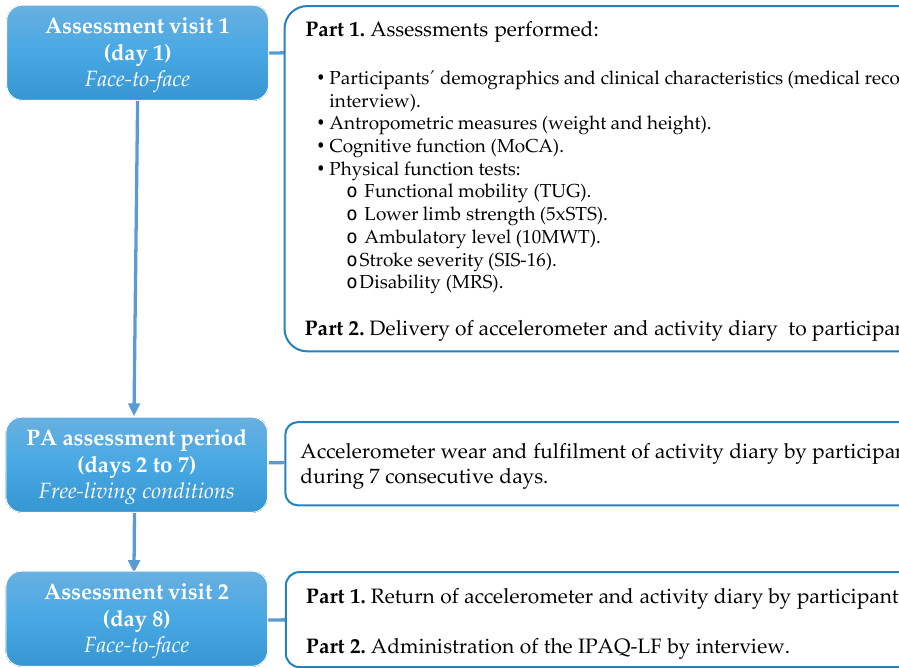
Figure 1. Flowchart of the study design. PA: physical activity; MOCA: Montreal Cognitive Assess- ment; TUG: timed up and go test; 5 × STS: five times sit-to-stand test; 10 MWT: ten-meter walk test; SIS-16: Stroke Impact Scale 16; MRS: Modified Rankin Scale; IPAQ-LF: International Physical Activity Questionnaire Long